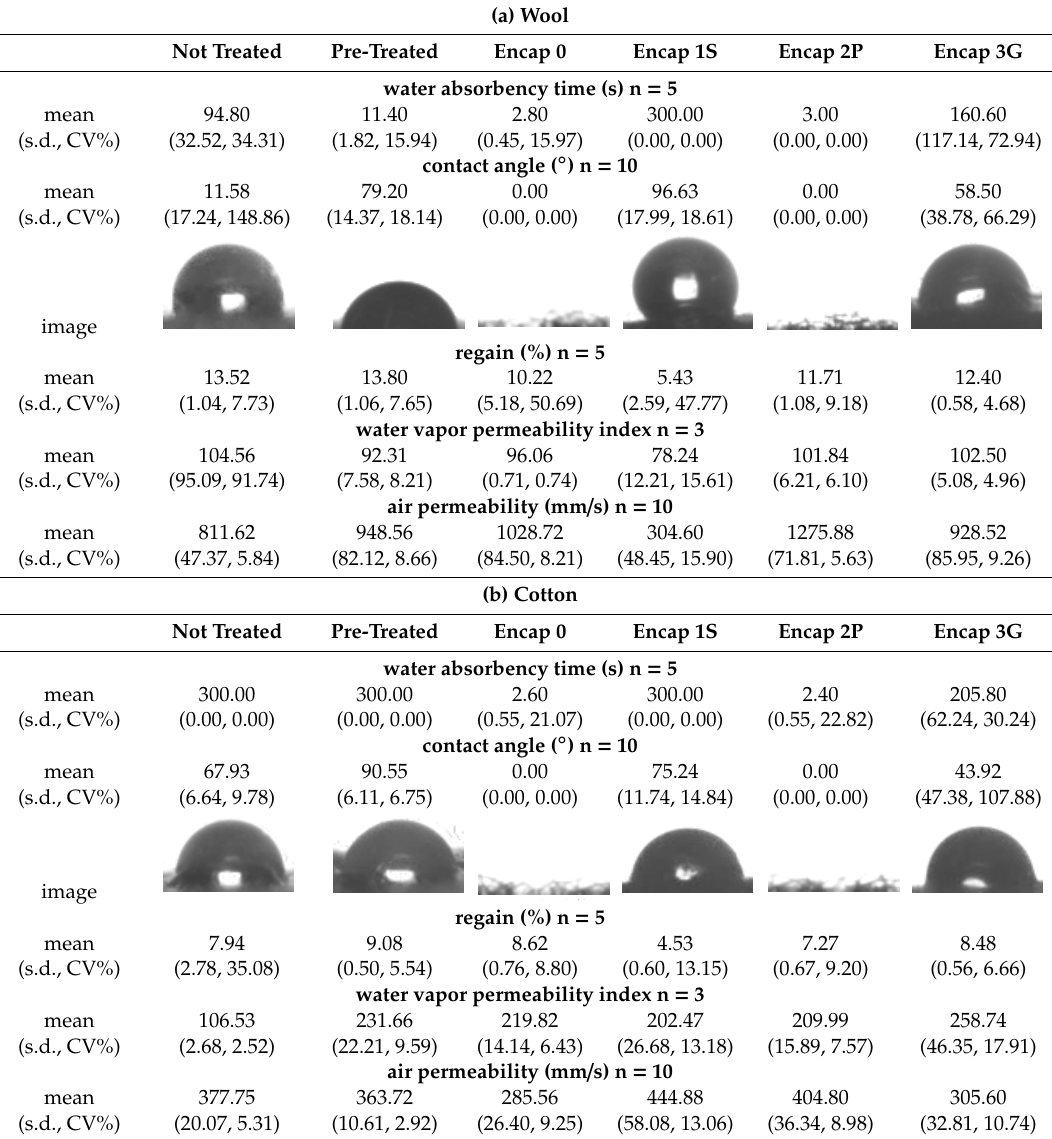
Table 2. E ff ects of functionalization on fabric moisture transfer and permeability to air. Table 2. Effects of functionalization on fabric moisture transfer and permeability to air. Table 2. Effects of functionalization on fabric moisture transfer and permeability to air. Table 2. Effects of functionalization on fabric moisture transfer and permeability to air. Table 2. Effects of functionalization on fabric moisture transfer and permeability to air. Table 2. Effects of functionalization on fabric moisture transfer and permeability to air. Table 2. Effects of functionalization on fabric moisture transfer and permeability to air. Table 2. Effects of functionalization on fabric moisture transfer and permeability to air. Table 2. Effects of functionalization on fabric moisture transfer and permeability to air. Table 2. Effects of functionalization on fabric moisture transfer and permeability to air. Table 2. Effects of functionalization on fabric moisture transfer and permeability to air. Table 2. Effects of functionalization on fabric moisture transfer and permeability to air. Table 2. Effects of functionalization on fabric moisture transfer and permeability to